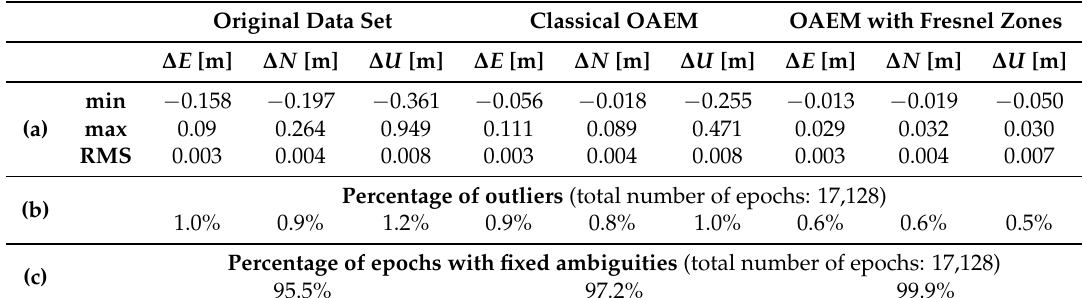
Table 2. ( a ) Minimum and maximum coordinate differences for the East-, North- and Up-component time series and the respective root-mean-squared error (RMS). ( b ) Percentage of outliers with respect to the 3 σ boundary. ( c ) Percentage of observation epochs with fixed carrier phase